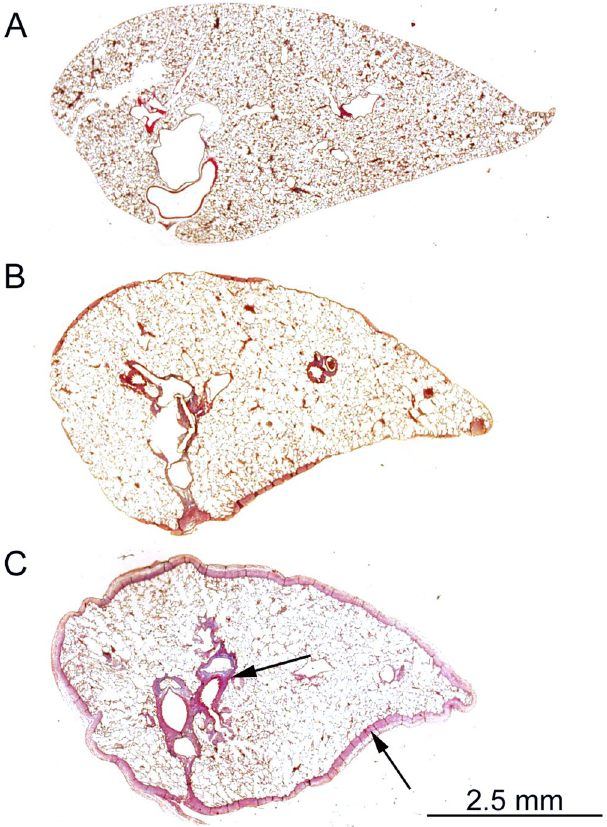
Figure 2. Dox produced pleural fibrosis and peribronchial fibrosis (indicated by arrow): ( A ), Control; ( B and C ) moderate and severe pleural fibrosis in the presence of Dox